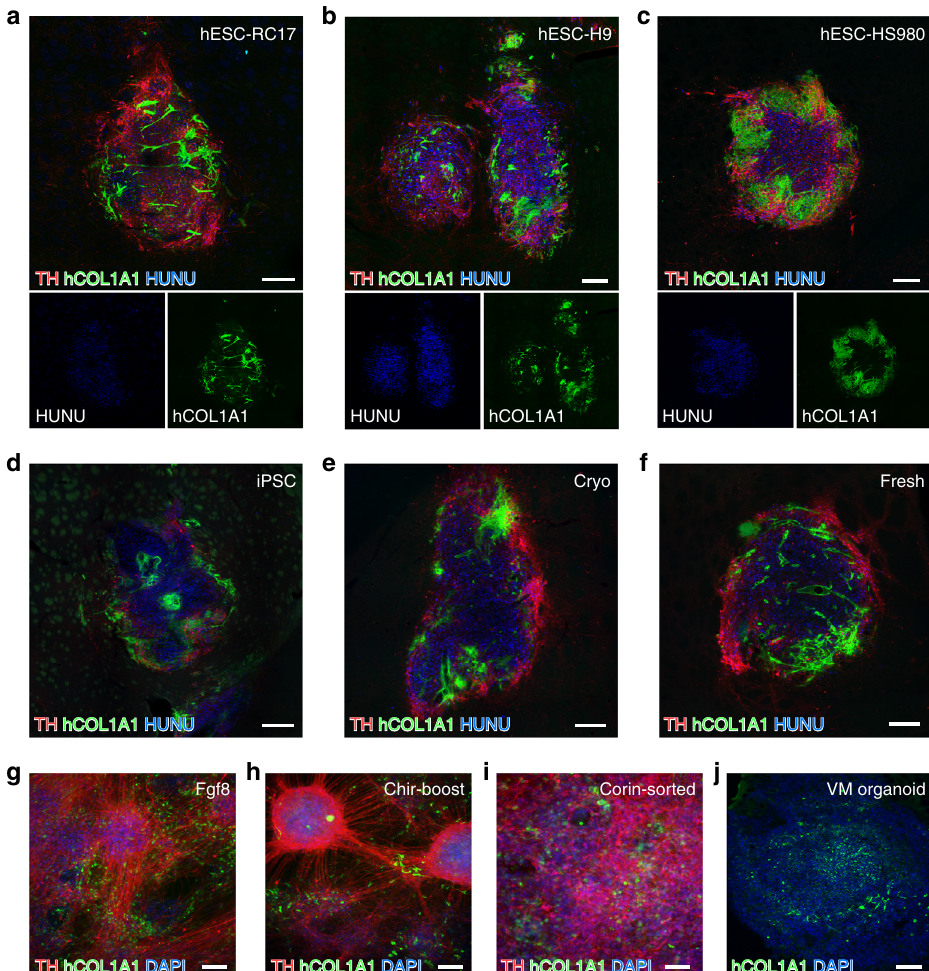
Fig. 3 Presence of VLMCs in different cell lines. a – c Representative immuno fl uorescence micrograph showing staining of hCOL1A1 in TH-rich hESC- derived grafts from three additional grafting experiments where the transplant was generated from VM-patterned RC17 ( a ), H9 ( b ) 25 , and HS980 hESC lines ( c ) 4 . d TH/hCOL1A1 immuno fl uorescence staining of a VM-patterned iPSC-transplant sorted for IAP expression prior to transplantation 25 . e , f TH / hCOL1A1 immuno fl uorescence staining of VM-patterned hESC-derived grafts generated from cryopreserved cells ( e ) or fresh cells ( f) . g – i Representative micrographs of TH/hCOL1A1 double immunostaining in terminally differentiated hESC in vitro cultures derived by three different clinically relevant VM- patterning differentiation protocols: the protocol used in this study ( g ), a protocol developed in the Studer lab that uses CHIR boost instead of FGF8 for proper caudalization (described in https://patents.justia.com/patent/20180094242) ( h ), and a protocol developed by the Takahashi lab where the cells are sorted based on Corin prior to grafting 12,26 ( i )). Nuclei were counterstained with DAPI in all three cultures. j hCOL1A immunostaining in a self- organized midbrain patterned organoid. Scale bars, 200 µ M ( a – f ) and 100 µ M ( g – j